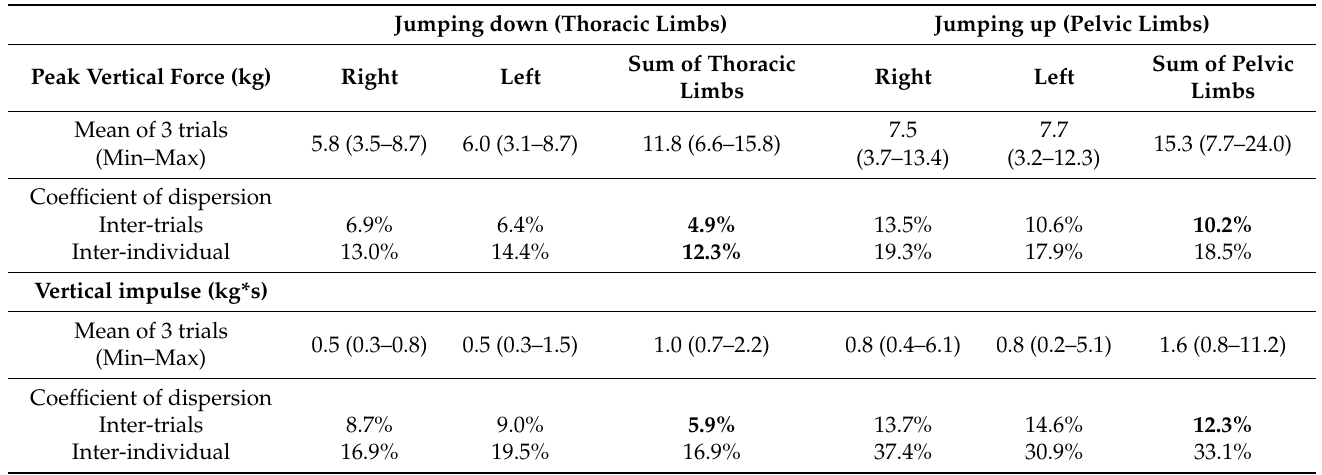
Table 1. Effort Path values of the first Baseline acquisition